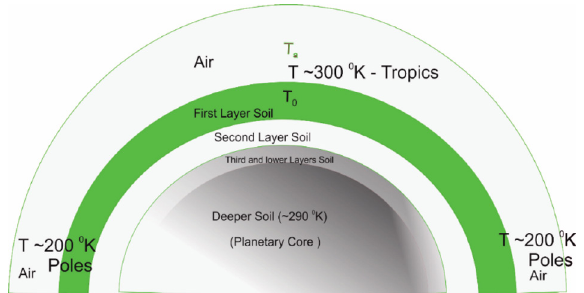
Fig. 5. The planetary soil and inert atmosphere (air) with a higher temperature T than solid layers at a greater